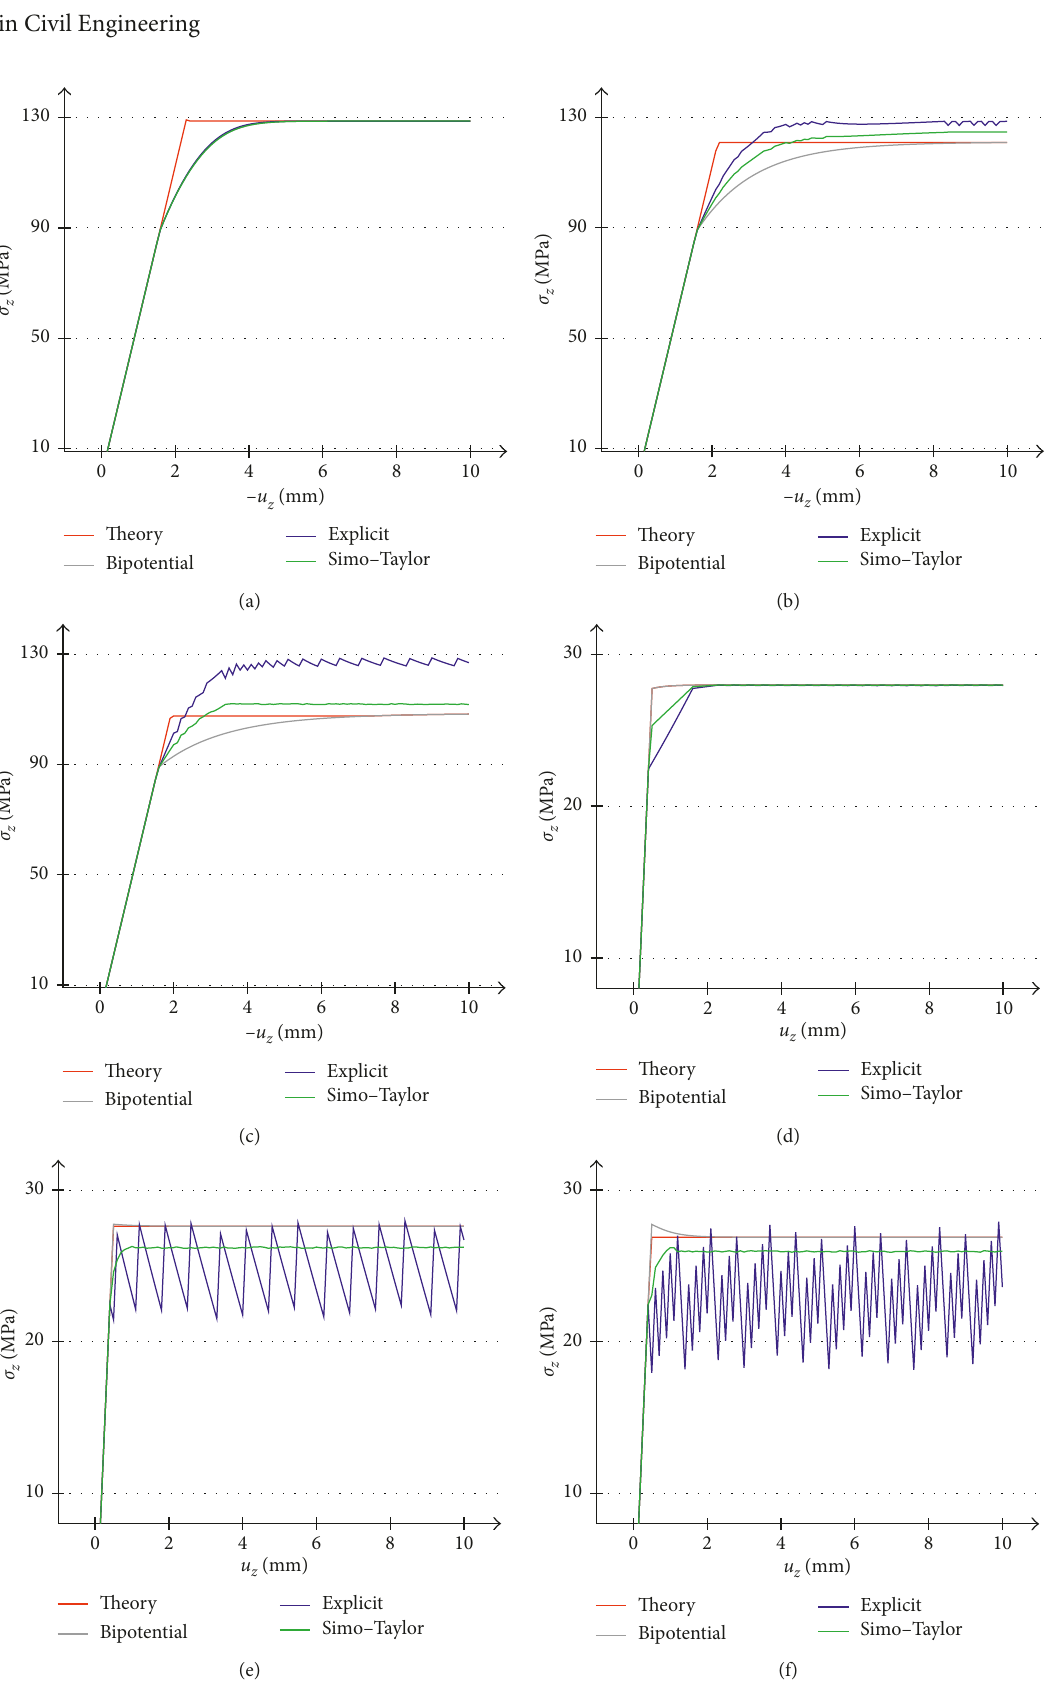
40 ° , (e) θ 20 ° , and (f) θ 0 ° (cid:31) (cid:31) (cid:31)